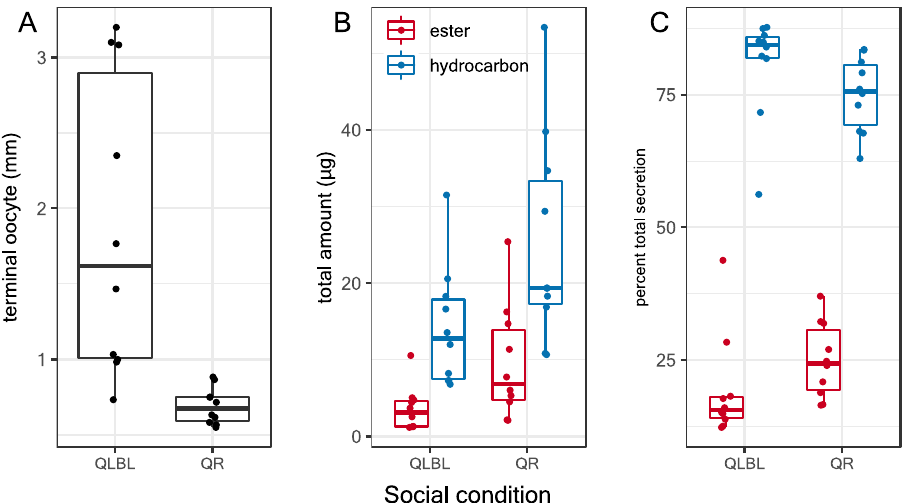
Figure 4. Reproductive state and Dufour’s gland chemistry of 6–7 day old workers in queenless (QR) and queenless-broodless (QLBL)groups. ( A ) mean terminal oocyte size (mm), ( B ) mean µg of total esters and hydrocarbons ± SE (n = 10), and ( C ) mean percent of total esters and hydrocarbons ± SE (n = 10). Each data point is the value from an individual worker.